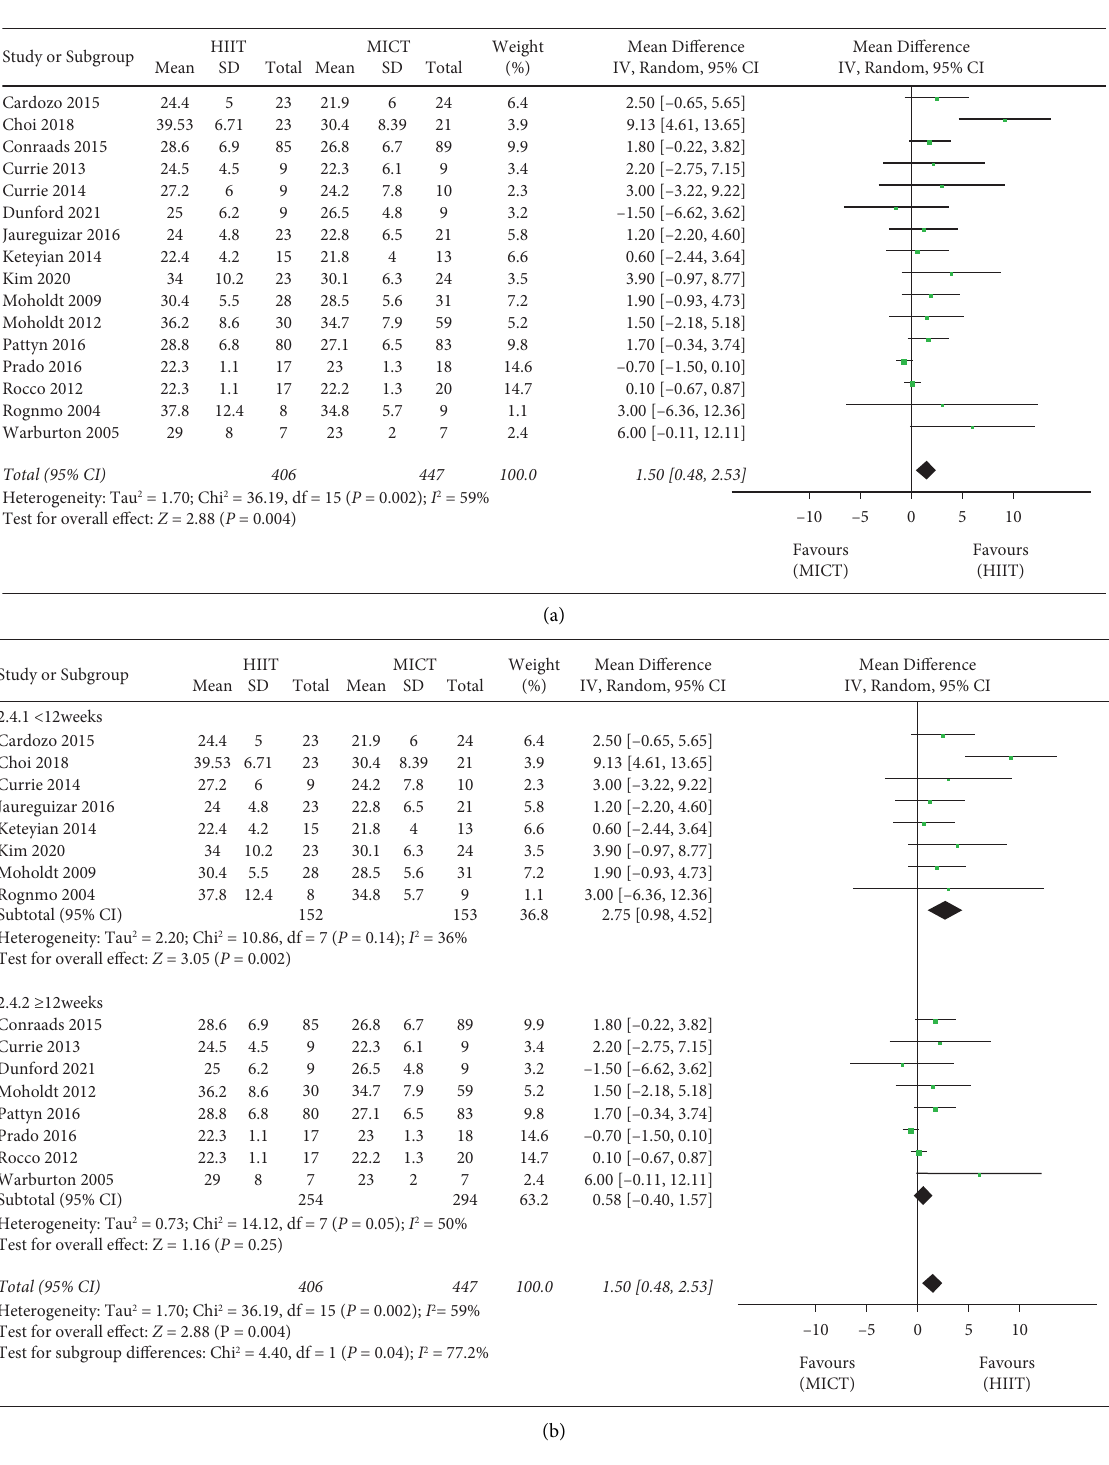
Figure 3: Meta-analysis results for VO